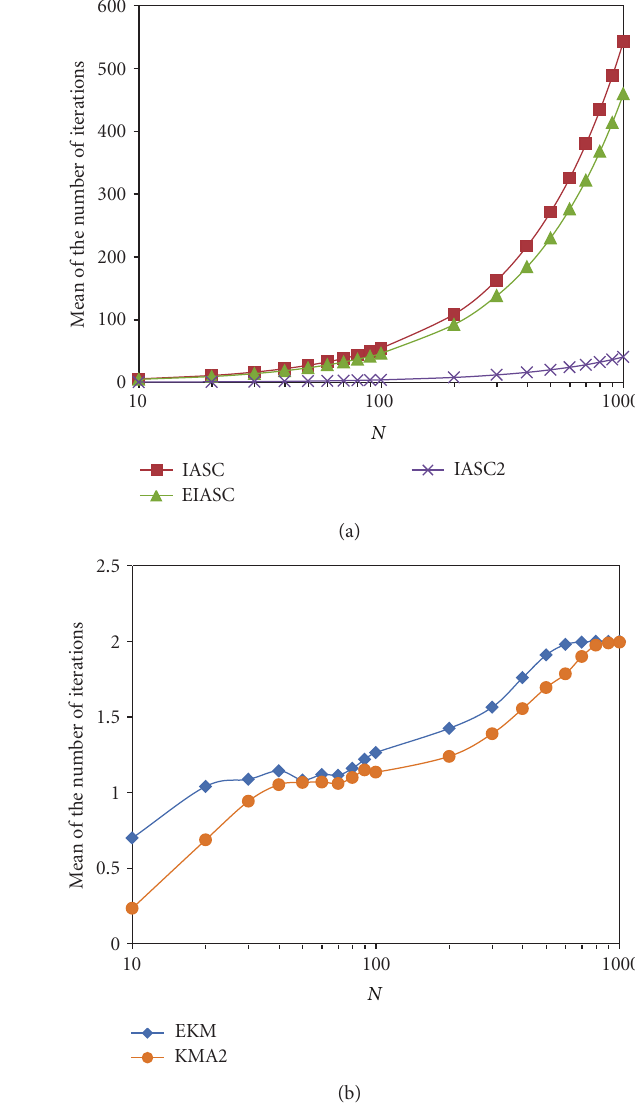
Figure 7: Uniform random FOU, iterations, (a) IASC-type algo- rithms and (b) KM-type algorithms.